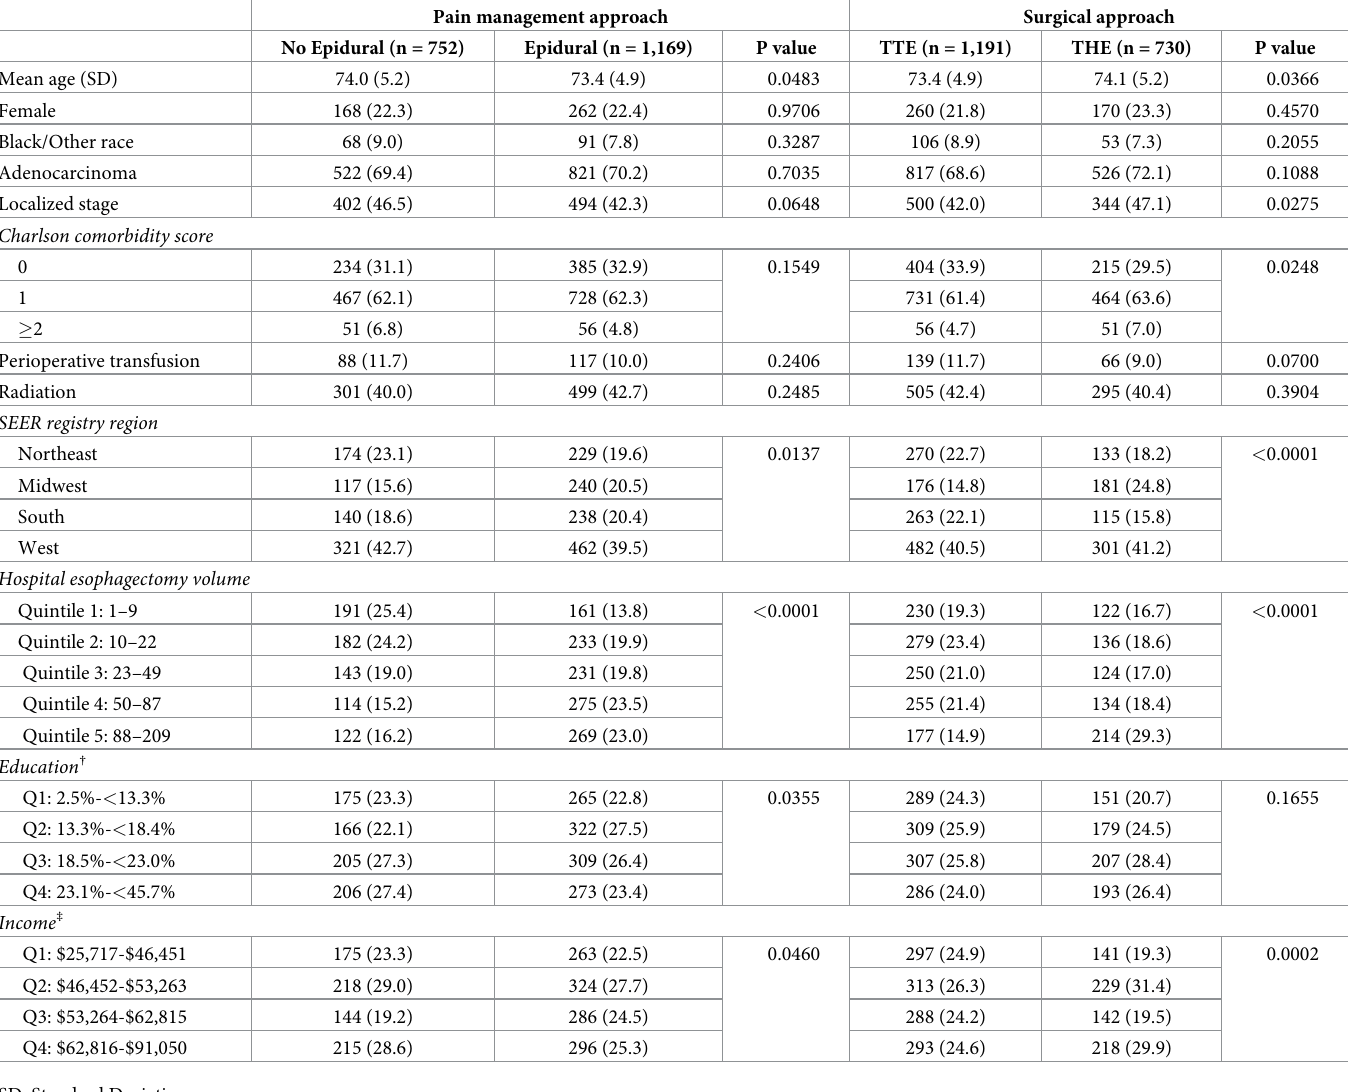
Table 1. Baseline characteristics in cohort by pain management approach and surgical